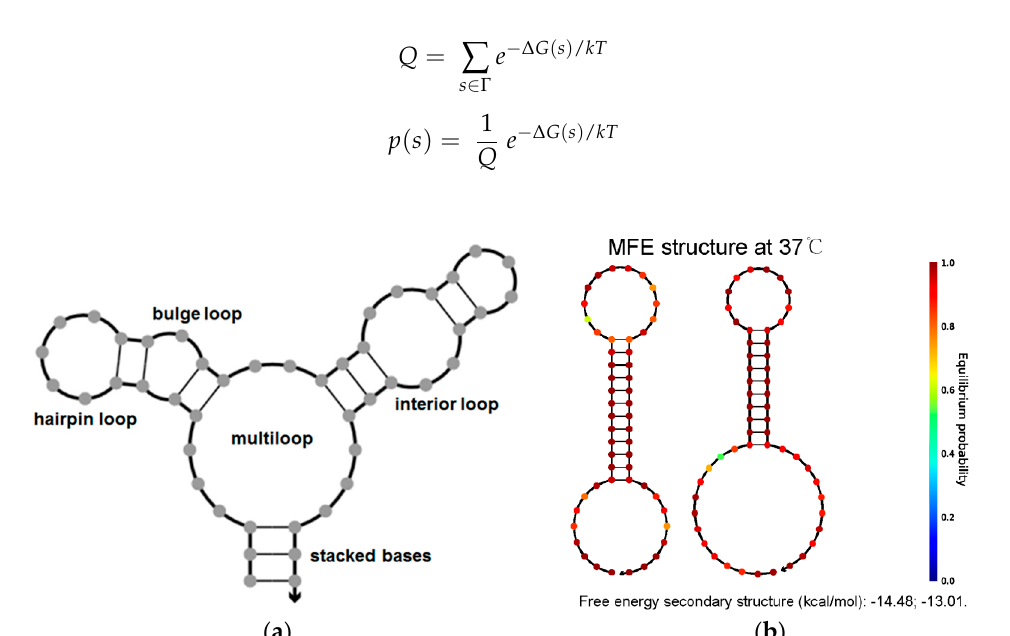
Figure 2. ( a ) Canonical loops of nucleic acid secondary structure; ( b ) The MFE structure of H1 and H2 by simulation.